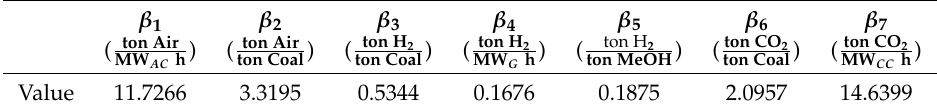
Table 3. The values of parameter β